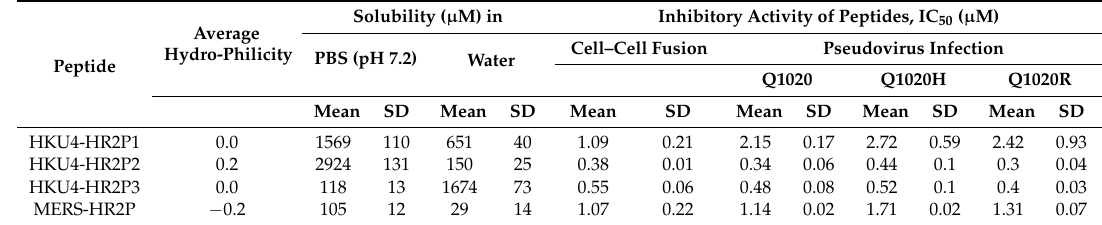
Table 1. Solubility and inhibitory activities of